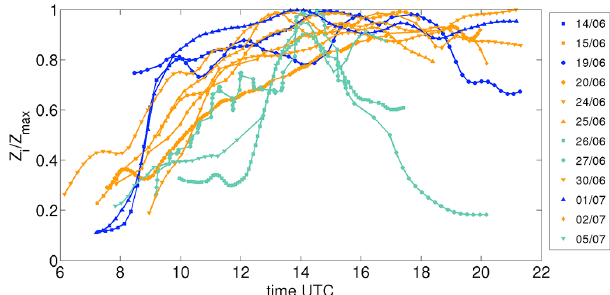
Figure 9. Evolution of the CBL top, defined here as height of the top inversion Z i , for all IOPs. Z i is divided by its maximum value reached the same day for day-to-day comparison, and has been smoothed with a 1h moving average. The estimates are made from lidar backscatter at site 1, except for day 26 June when the UHF radar estimates were used instead, due to missing data. One symbol is used per IOP. Three sets of cases have been identified: (blue) rapid growth and levelling inversion in late afternoon, (orange) more typ- ical growth and levelling inversion and (green) slower growth and rapidly decreasing top inversion in late